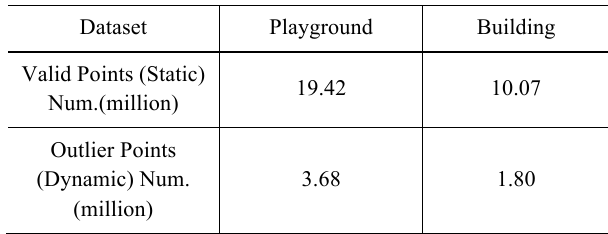
Table. 3 Quantitative evaluation of the dynamic object detection